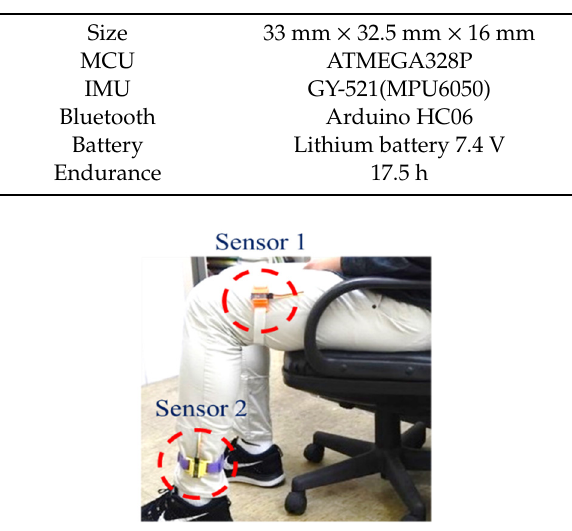
Figure 3. Developed sensor device.